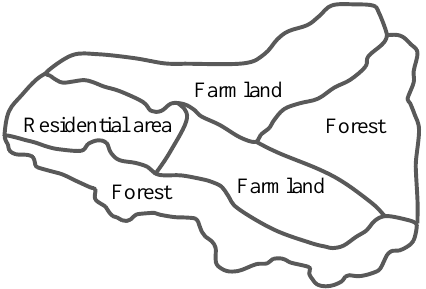
Figure 3. An example of a Primary Sample Unit (PSU) with five plots and three categories of land use (farmland, forest, and resi- dential